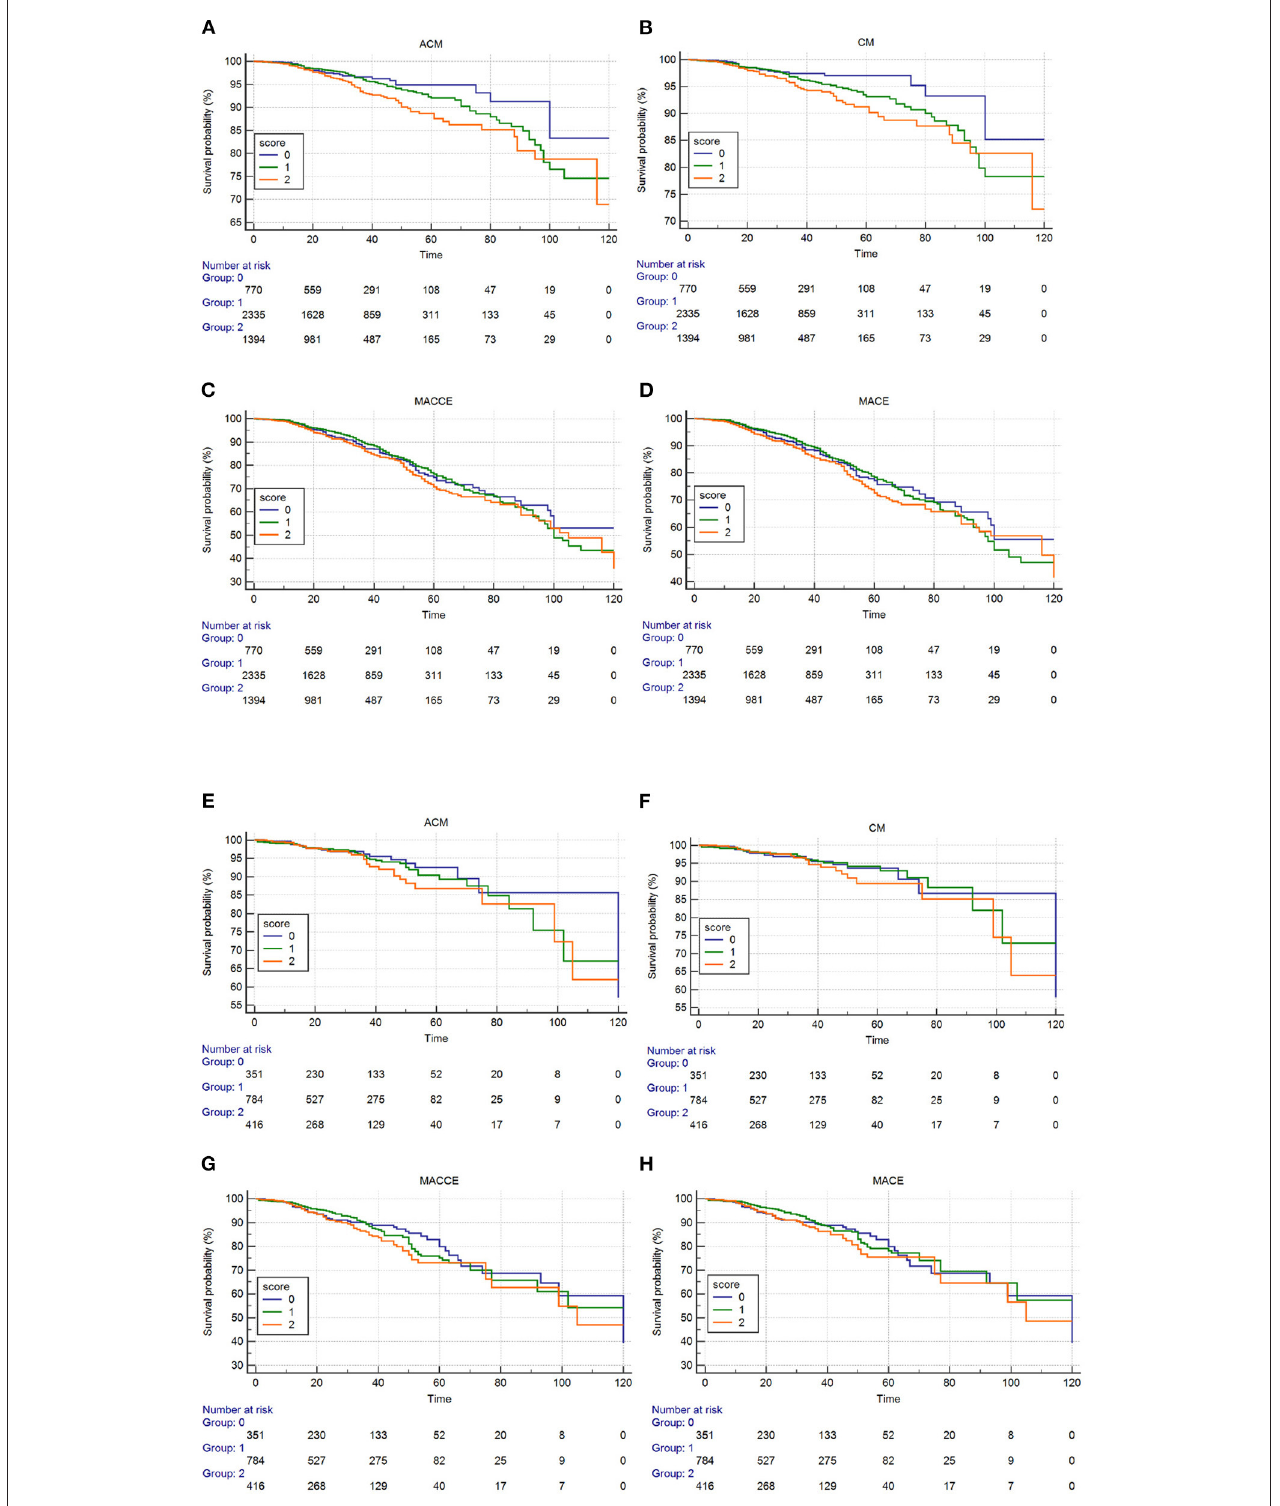
FIGURE 3 | Cumulative Kaplan–Meier estimates of the time to the first adjudicated occurrence of primary endpoint and secondary endpoints. Male (A–D) : (A) ACM; (B) CM; (C) MACCEs; (D) MACE. Female (E–H) : (E) ACM; (F) CM; (G) MACCEs; (H) MACE.